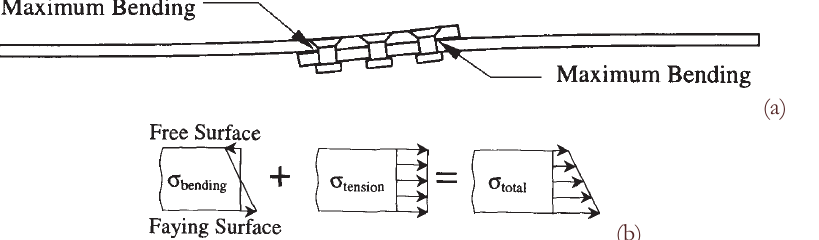
Figure 1: Deformed lap-joint undergoing a traction load with highlight of sites undergoing maximum bending stresses (a) and stress distribution through the thickness of the sheet